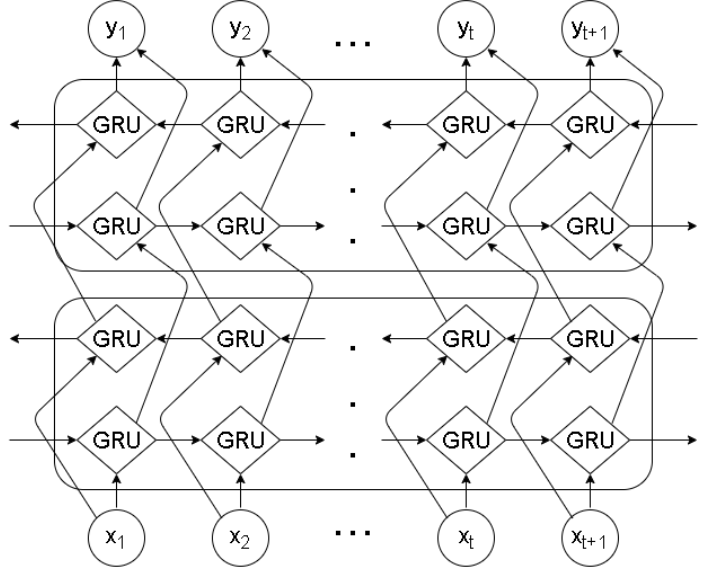
Figure 2. Structural unit of the Bi-GRU neural